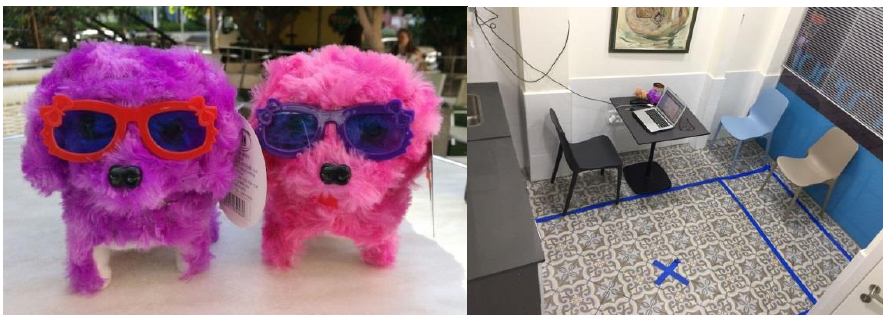
Figure 1 . Example of the type of robot used and the experimental setup.